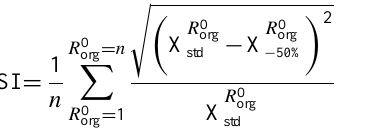
Using the default parameter set listed in Table 1, this threshold ratio was equal to 28.99. Above 28.99, deep N con- centrations increased linearly, while deep P